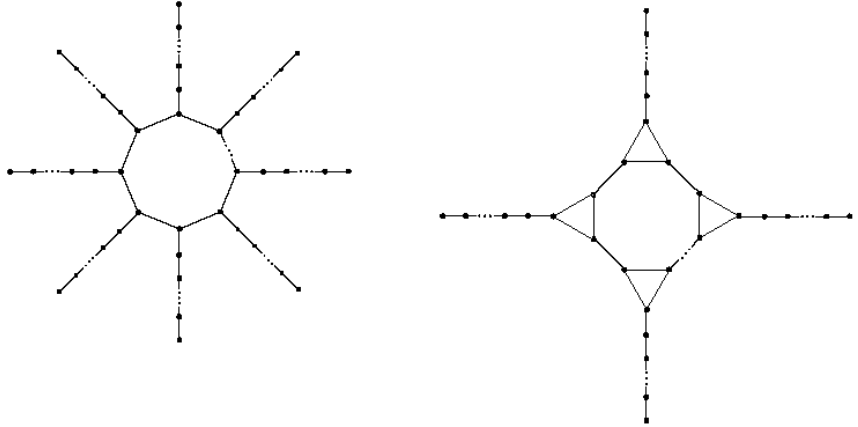
Figure 1. The graph of C n { P k } ; Line graph of the subdivision graph of C n { P k }